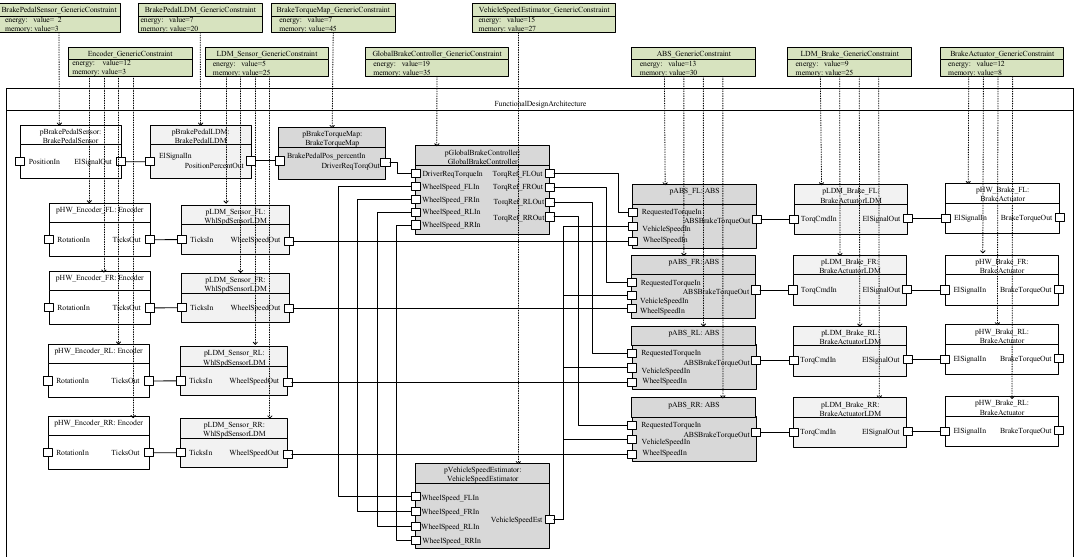
Figure 5. An overview of the Brake-by-Wire (BBW) system and its resource